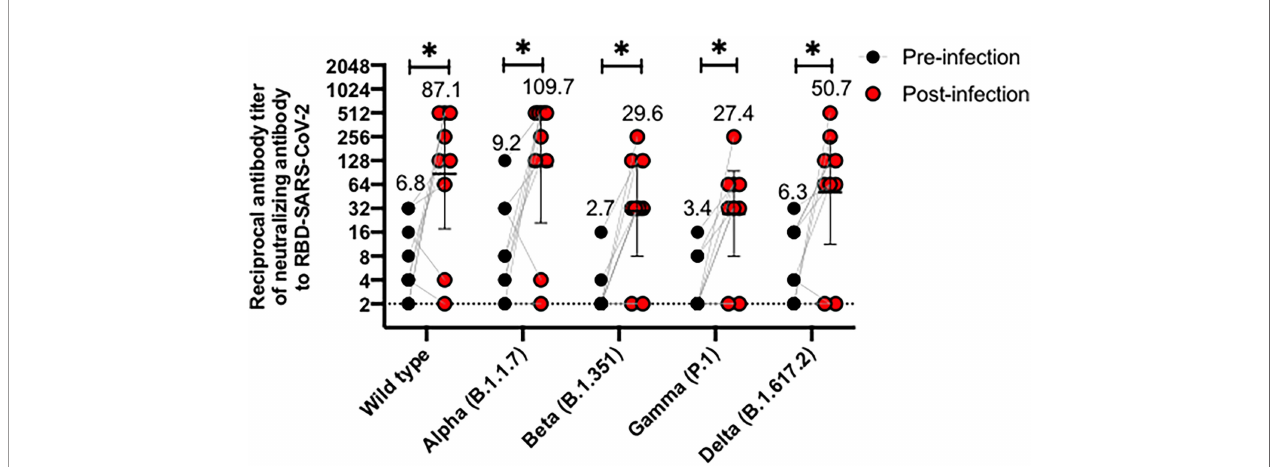
FIGURE 3 | CoronaVac immunization induces antibodies able to inhibit the interaction between hACE2 and S1-RBD from SARS-CoV-2 variants in vaccine breakthrough cases after two vaccine doses. Antibody titers were evaluated with a surrogate virus neutralization assay (sVNT), which quanti fi es the interaction between S1-RBD from either Wild type SARS-CoV-2 or variants of concern (Alpha, Beta, Gamma, and Delta) and hACE2 on ELISA plates. Comparative data from vaccine breakthrough cases from both schedules are represented for each variant in two different point times, pre-infection (black circle) and post-infection (red circles). A Wilcoxon test analyzed data to compare against the wild-type RBD; *p < 0.05. The graph represents the results obtained for nine volunteers considering both schedules.